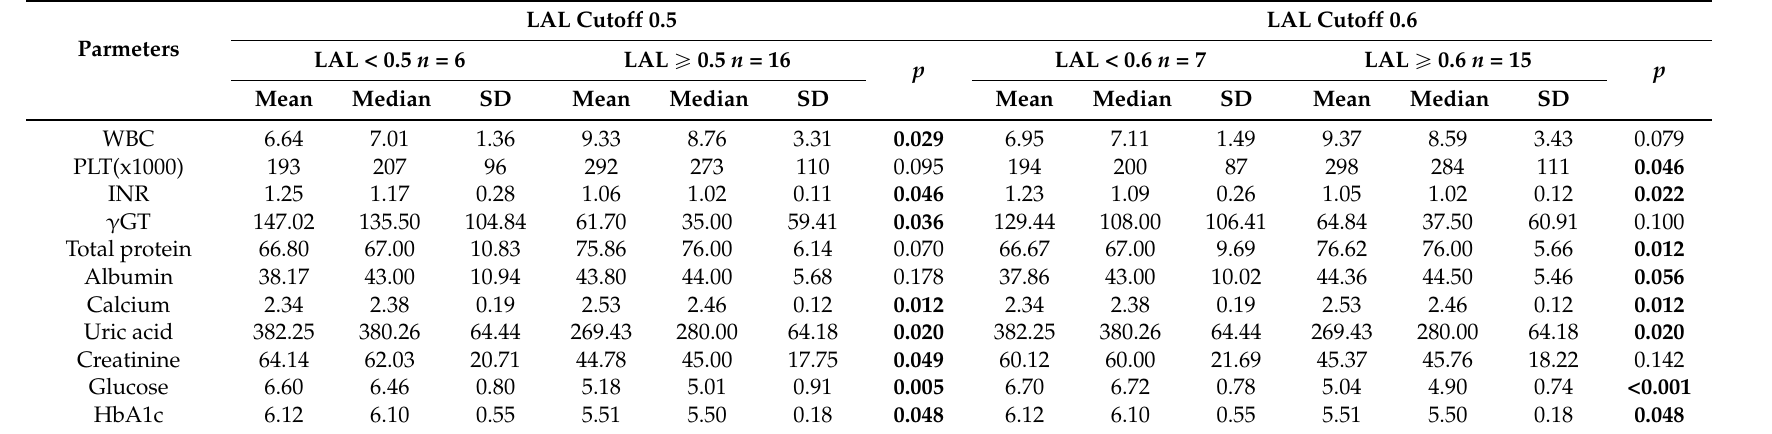
Table 4. Laboratory results of participants, according to LAL